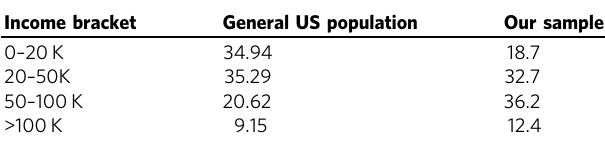
Table 1 Socioeconomic status of US population vs. our sample.